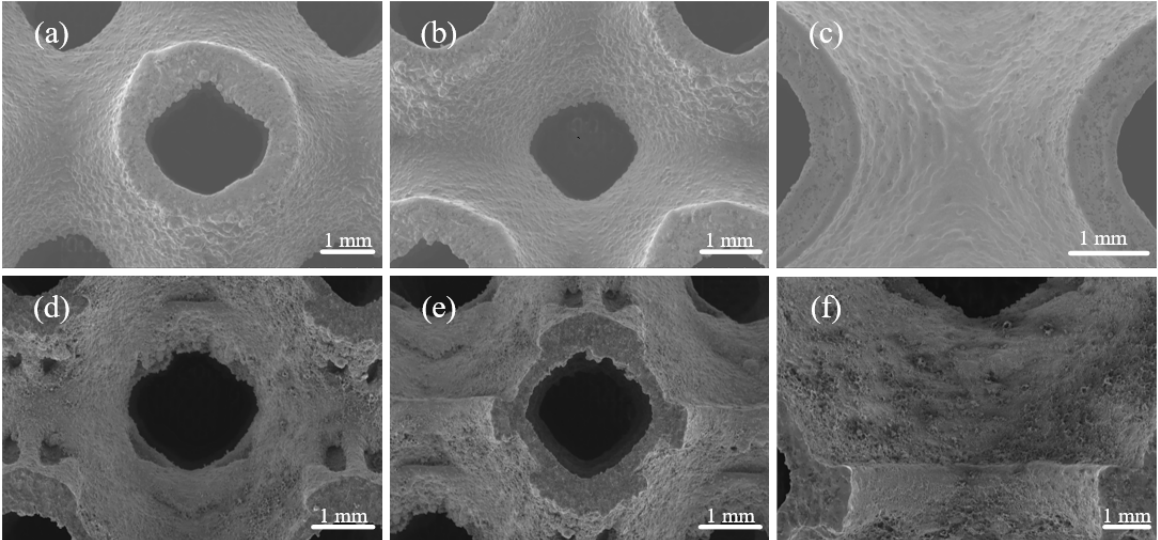
Figure 5. SEM images of the surface of fabricated parts. ( a – c ) Outer surface of P0.6C1 and ( d – f ) inner surface of P0.6C1.